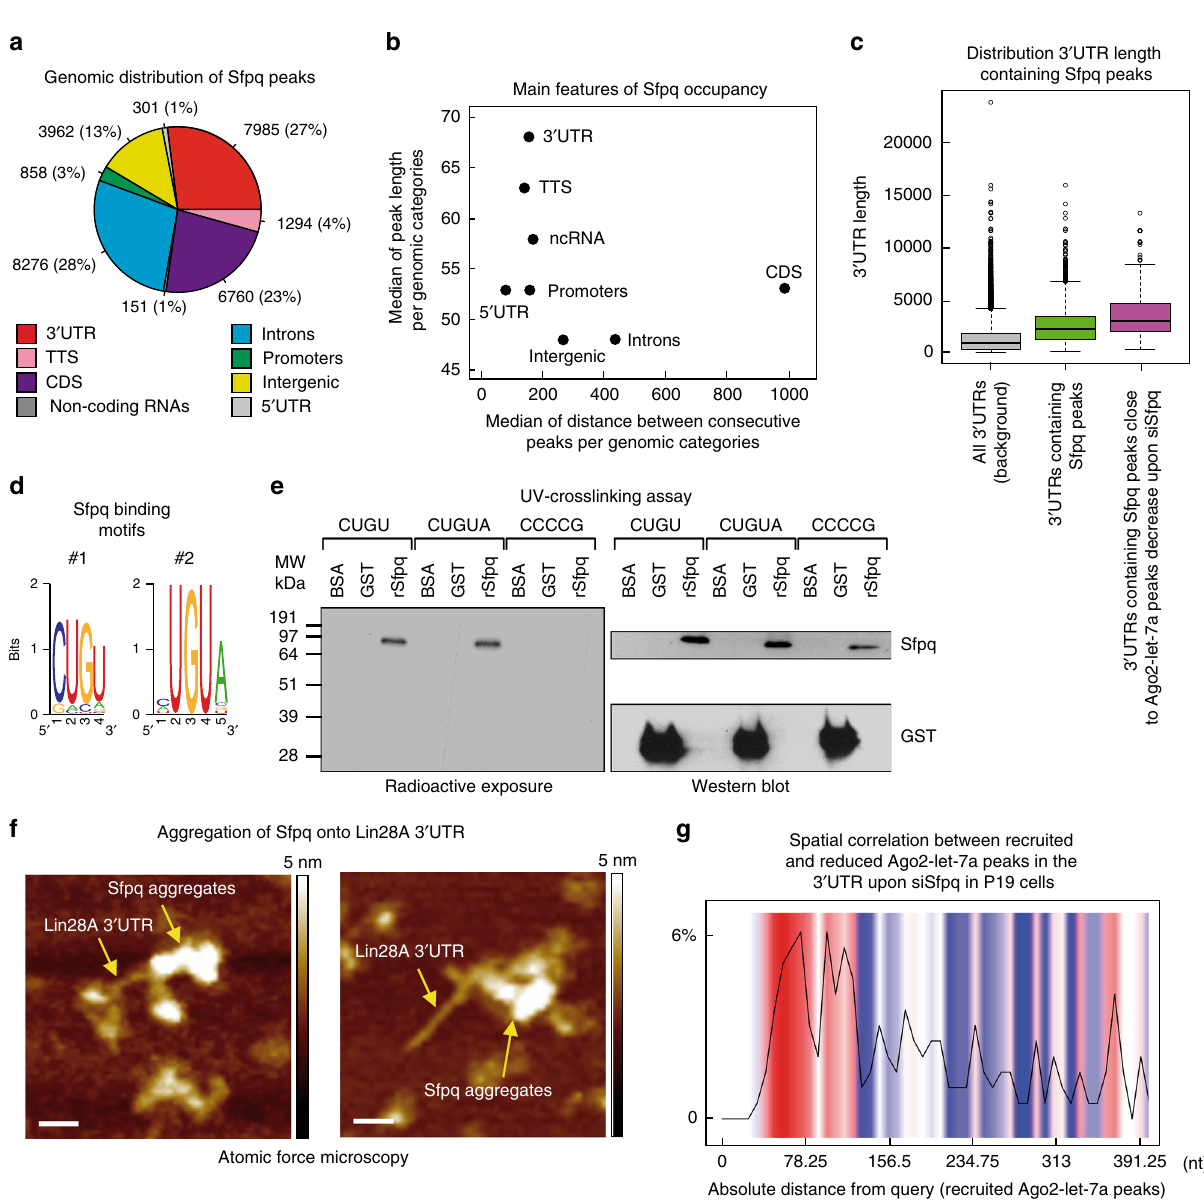
Absolute distance from query (recruited Ago2-let-7a peaks) to reference (reduced Ago2-let-7a peaks), p Fig. 6 Sfpq aggregates onto long 3 ′ UTRs to modulate the accessibility of miRNA-binding sites. a Genomic distribution of Sfpq peaks by HITS-CLIP analysis. b Scatter plot of length and frequency of Sfpq peaks in different genomic regions. c Distribution of the 3 ′ UTR length of the indicated subpopulation of transcripts. d Result of the bioinformatic analysis for de novo search of Sfpq-binding motif from Sfpq HITS-CLIP data. e UV-crosslinking assay to analyze the interaction of the recombinant Sfpq (100 nM) with the 32 P-labeled RNA oligonucleotides containing two copies of the CUGU or CUGUA, respectively, but not to the CCCCG negative control sequence. f Top view of two topographic AFM images of typical Sfpq-Lin28A 3 ′ UTR complexes. The color bar on the right represents the height scale with a maximum corresponding to 5 nm. Scale bar corresponds to 20 nm. g Spatial correlation of the recruited Ago2- let-7a peaks compared to the decreased ones. In the x -axis is reported the distance in nt between the reduced and the new recruited peaks on the 3 ′ UTR, whereas in the y -axis is reported the percentage of recruited peaks. The black line is the data density, the red bars indicate that the number of recruited peaks is higher than that expected by chance, the blue bars indicate the opposite, whereas the white bars indicate no